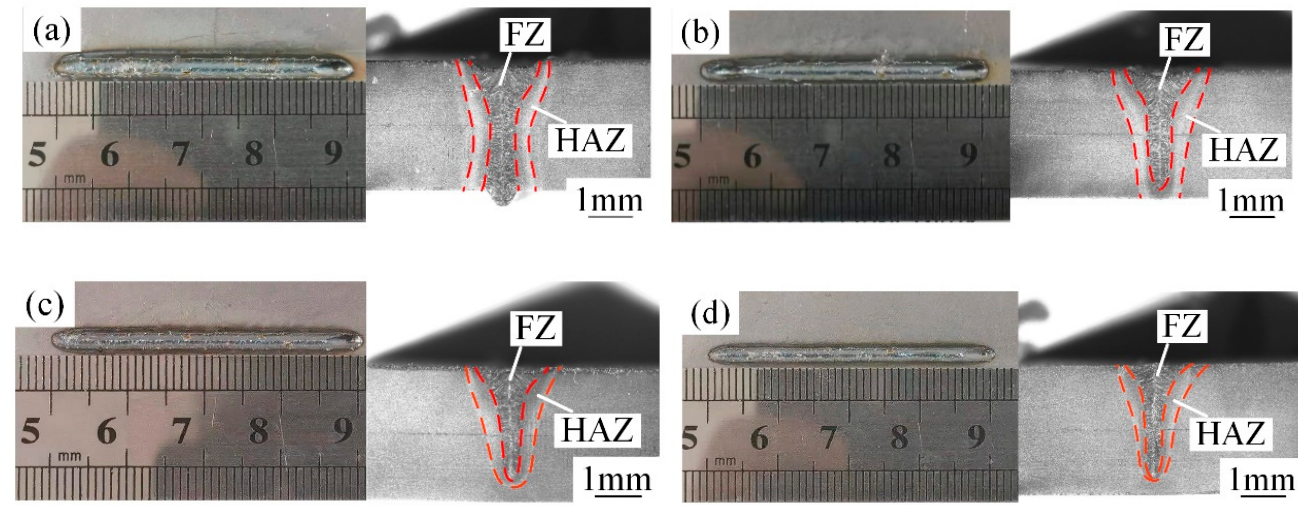
Figure 3. The front morphology and cross-sectional morphology of the weld under different welding speeds (mm/s): ( a ) 30, ( b ) 40, ( c ) 50 and ( d ) 60.